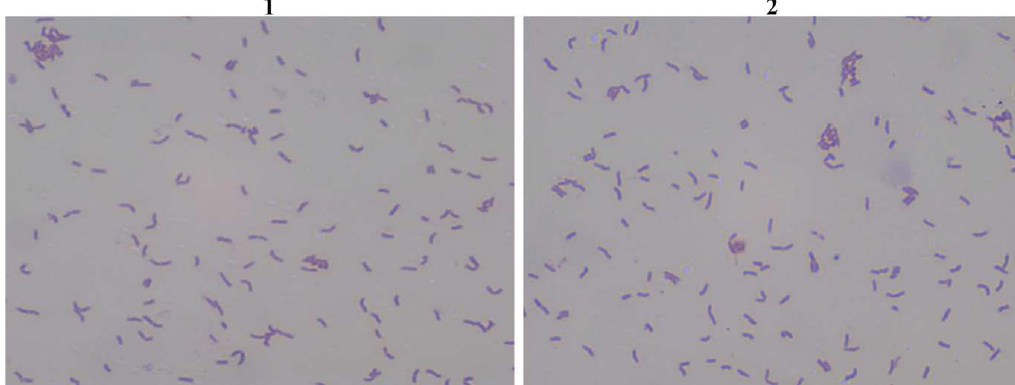
Fig. 3. Grams staining of the isolate to demonstrate snipping cell division (1-Strain HYJE003 and 2-Strain HYJE005